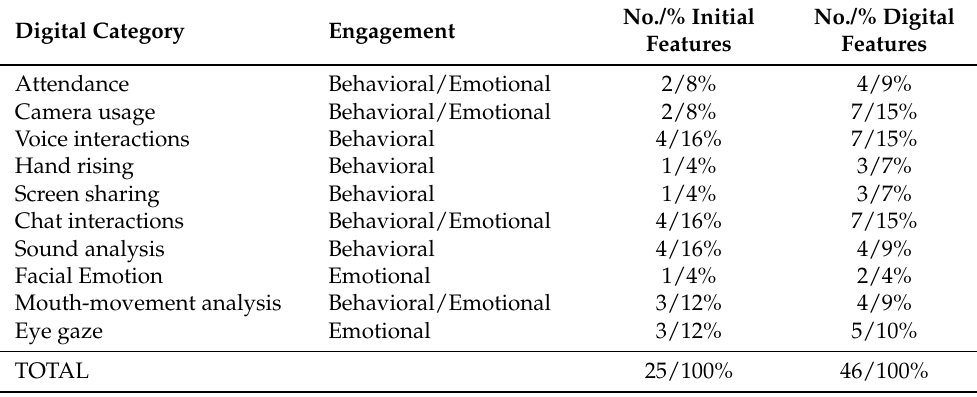
Table 17. Categorization of the identified features, 25 features classified in 10 digital